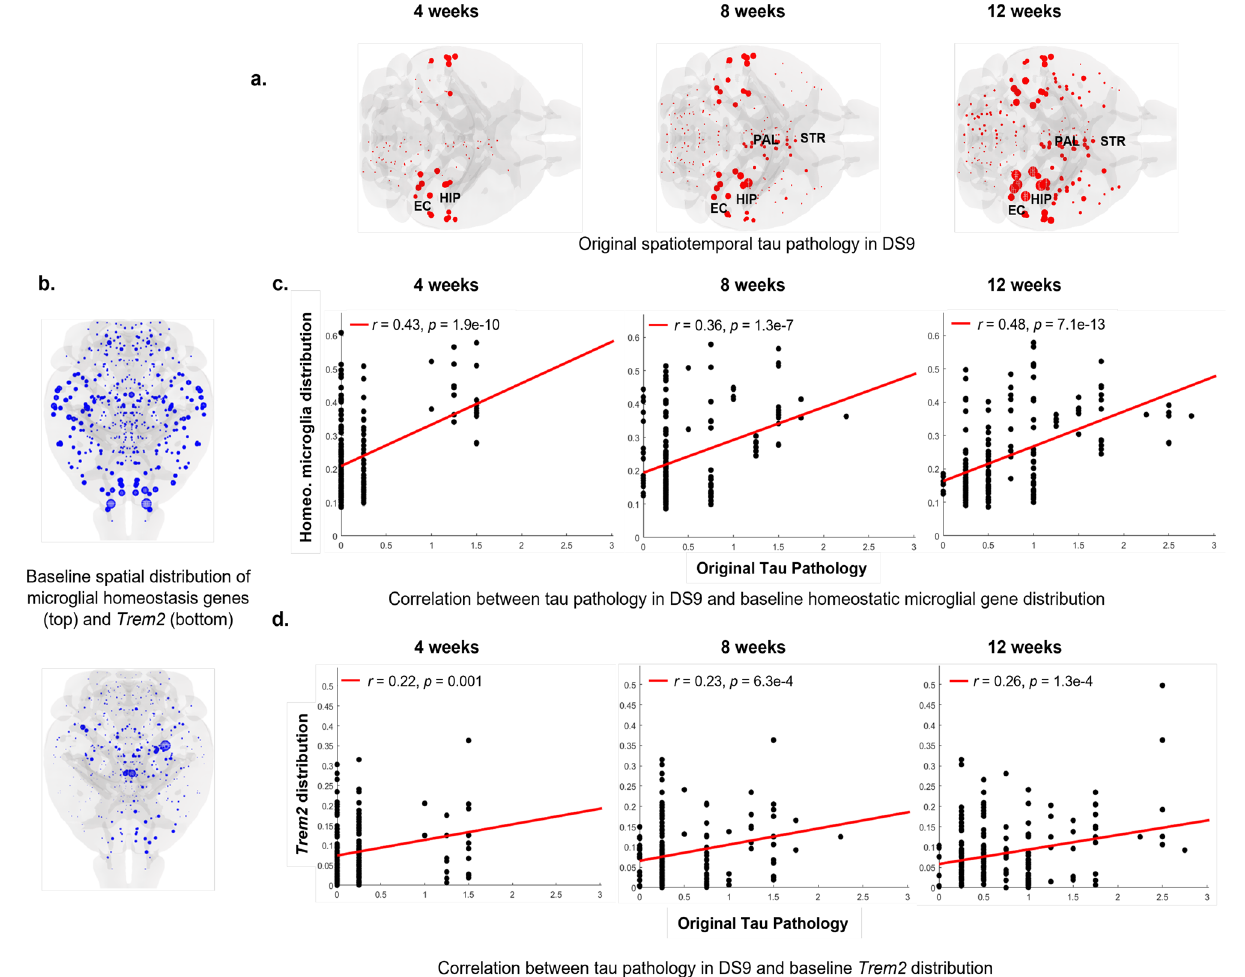
Figure 2. Correlation between spatiotemporal empirical tau pathology at 4, 8, and 12 weeks post hippocampal tau injection and baseline microglial gene spatial distribution for DS9. Panel ( a ): Empirical tau pathology in DS9 dataset post hippocampal seeding of exogenous tau 27 . Panel ( b ): Baseline spatial distribution of first principal component of microglial homeostasis genes and Trem2 from a healthy adult mouse 30 . Panels ( c ) and ( d ): Correlation between spatiotemporal tau pathology progression at 4, 8, and 12 weeks post hippocampal seeding, and baseline expression levels of microglial homeostasis genes as well as Trem2 . Sphere sizes in panel a correspond to the degree of tau burden in specific brain regions. HIP, hippocampus; EC, entorhinal cortex; PAL, pallidum; STR,